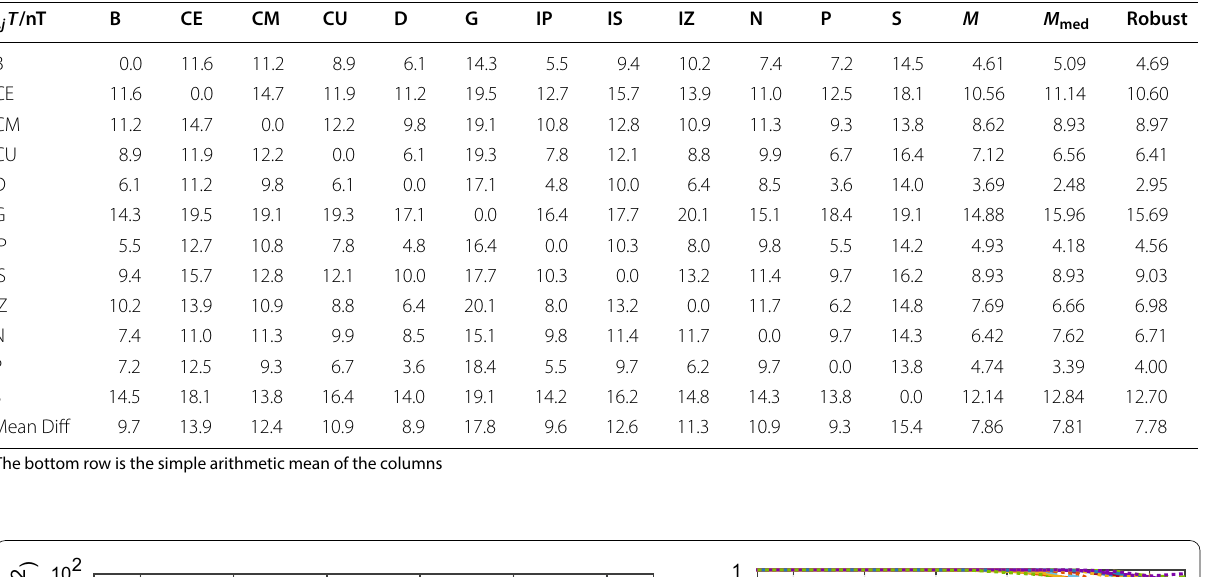
Table 4 Root-mean-square vector field differences i , j T in units nT between IGRF-2020 candidate models and also between candidates and the arithmetic mean reference models M , median reference model M med and robust Huber-weighted model in the rightmost columns i , j T /nT